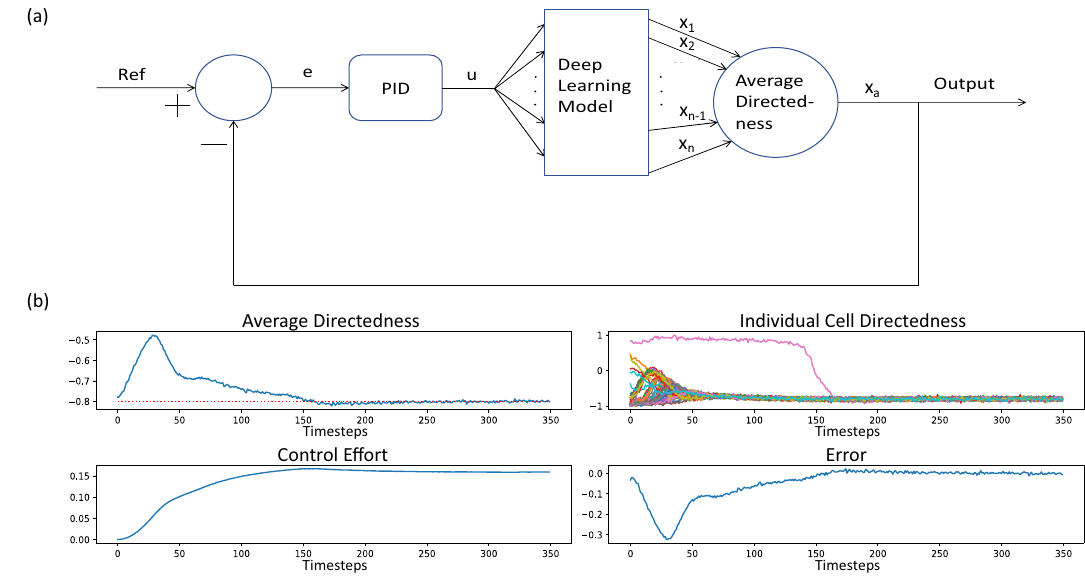
Figure 9. ( a ) The top figure depicts the closed loop design. A reference value/trajectory is picked. The error is evaluated and fed to the PID. The PID uses this value to determine the appropriate EF in order to guide the average directedness towards the reference. This EF is applied to the model of cell migration. ( b ) (Bottom upper left) The average directedness of all the cells (the dashed red line indicates the reference value). (Bottom upper right) The directedness of individual cells. (Bottom lower left) The voltage being applied throughout the simulation to get the appropriate response. (Bottom lower right) The error of the average directedness in relation to the reference